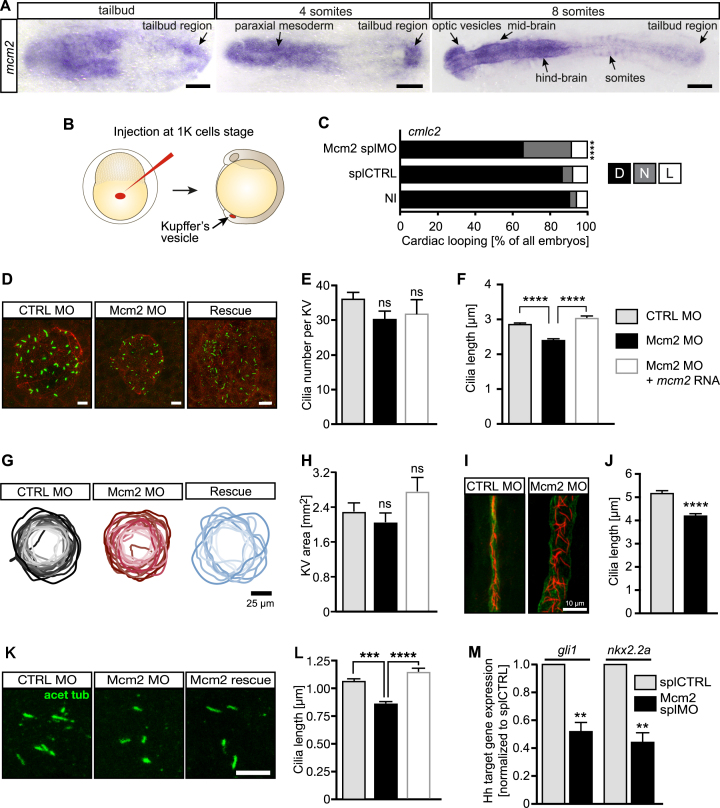
Impaired left-right asymmetry development upon Mcm2 knockdown is accompanied by shorter cilia. (A) Expression of mcm2 in the tailbud of zebrafish embryos. Scale bars: 150 μm (tailbud and 4ss), 200 μm (8 ss). (B) Injection strategy to target KV cells. (C) Randomized heart looping after KV-specific Mcm2 ablation. P = 0.0007, two-tailed Fisher's exact test. n = 4 experiments. Number of embryos: NI = 121; splCTRL = 115; Mcm2 splMO = 118. (D) Confocal stacks of motile cilia (green) in the KV of 6–8 ss embryos injected with Mcm2 control or Mcm2 translation blocking MO. Cilia were labelled using an anti-acetylated tubulin antibody. Apical cell borders for visualization of the KV area were stained with an anti-PKCζ antibody (red). Scale bar: 10 μm. (E) Cilia numbers are not changed in the KV of Mcm2 morphants. P = 0.1403 (CTRL MO vs Mcm2 MO), p>0.9999 (Mcm2 MO/Ctrl Mo vs Rescue). Kruskal–Wallis test with Dunn's multiple comparisons test. In four experiments 29 CTRL MO, 28 Mcm2 MO and 12 Rescue KVs were assessed. (F) Depletion of Mcm2 results in shorter KV cilia, which can be rescued by co-injection of MO-insensitive RNA encoding Mcm2. P < 0.0001. Kruskal–Wallis test with Dunn's multiple comparisons test. n = 4 with 920 CTRL MO and 870 Mcm2 MO and 243 Rescue cilia. (G) KV outlines at 6–8 ss. Darker colour reflects larger areas. Scale bar: 25 μm. (H) KV is not significantly altered upon Mcm2 knockdown or its rescue. n = 19 CTRL MO, 22 Mcm2 MO and 10 Rescue KVs. P = 0.7952 (Ctrl MO vs Mcm2 MO), P = 0.1425 (Mcm2 MO vs Rescue). Kruskal–Wallis test with Dunn's multiple comparisons test. (I) Confocal stacks of immunostained pronephric ducts (cilia: acetylated tubulin, red, duct: PKCζ, green) at 24 hpf. Dilatation of the pronephric duct as well as disorganization of cilia was seen in the majority of Mcm2 depleted zebrafish. Scale bar: 10 μm. (J) Distal cilia length in the pronephros is reduced upon Mcm2 knockdown. n = 10 CTRL MO and 8 Mcm2 MO embryos with 368 and 299 cilia, respectively. P < 0.0001. Two-tailed Mann–Whitney test. (K) Primary cilia in the tailbud of 6–8 ss embryos. Scale bar: 5 μm. (L) Primary cilia length is reduced in the presence of Mcm2 MO and restored, when co-injected with RNA encoding Mcm2. n = 375 (CTRL MO), 413 (Mcm2 MO) and 171 (Mcm2 rescue) cilia. P < 0.0001. Kruskal–Wallis test with Dunn's multiple comparisons test. (M) Hh pathway activity is dampened in Mcm2 depleted zebrafish as shown for the Hh target genes gli1 and nkx2.2a. P = 0.0018 (gli1) and P = 0.0013 (nkx2.2a), unpaired, two-tailed t-test with Welch's correction. n = 5 experiments.